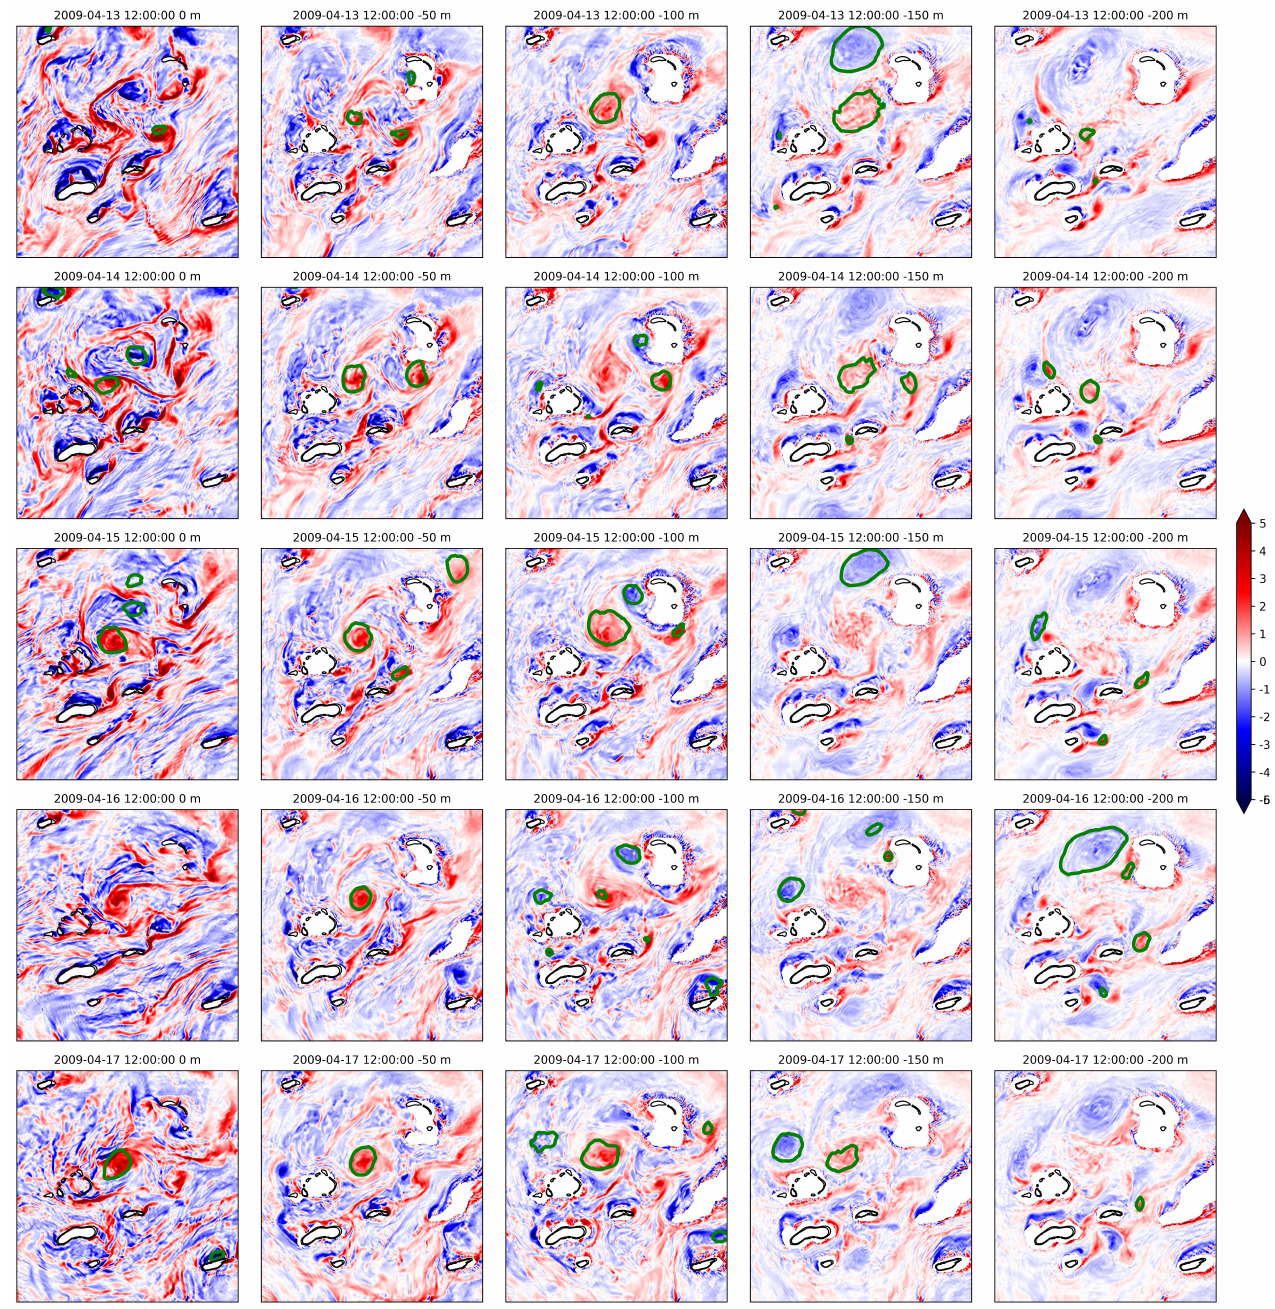
200 m) downstream of reefs and atolls ∼